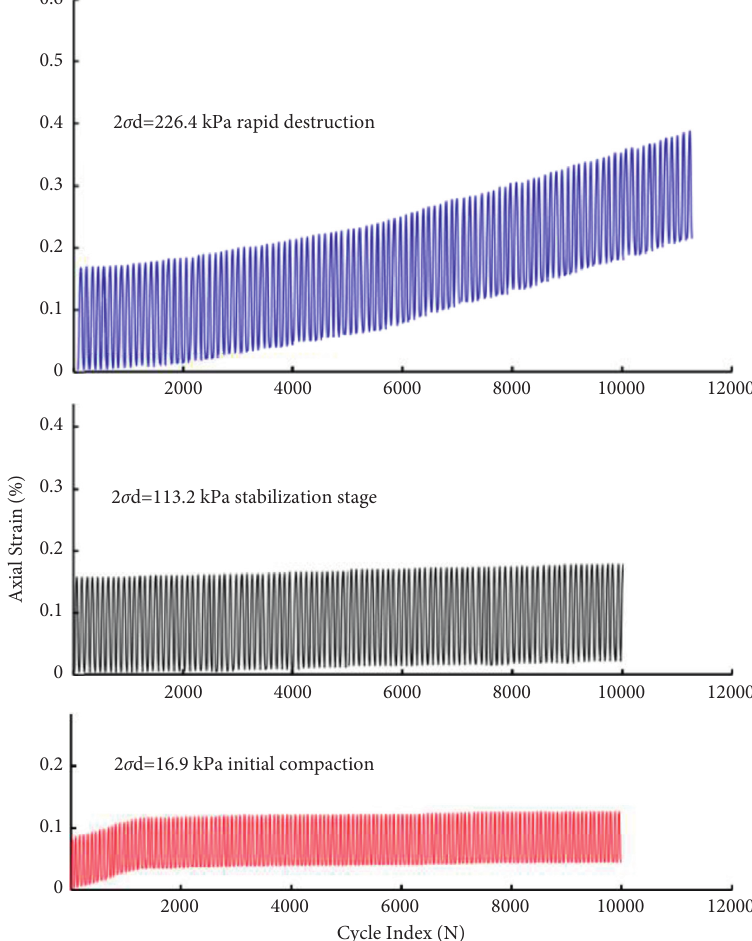
Figure 5: Axial strain versus loading cycles N .